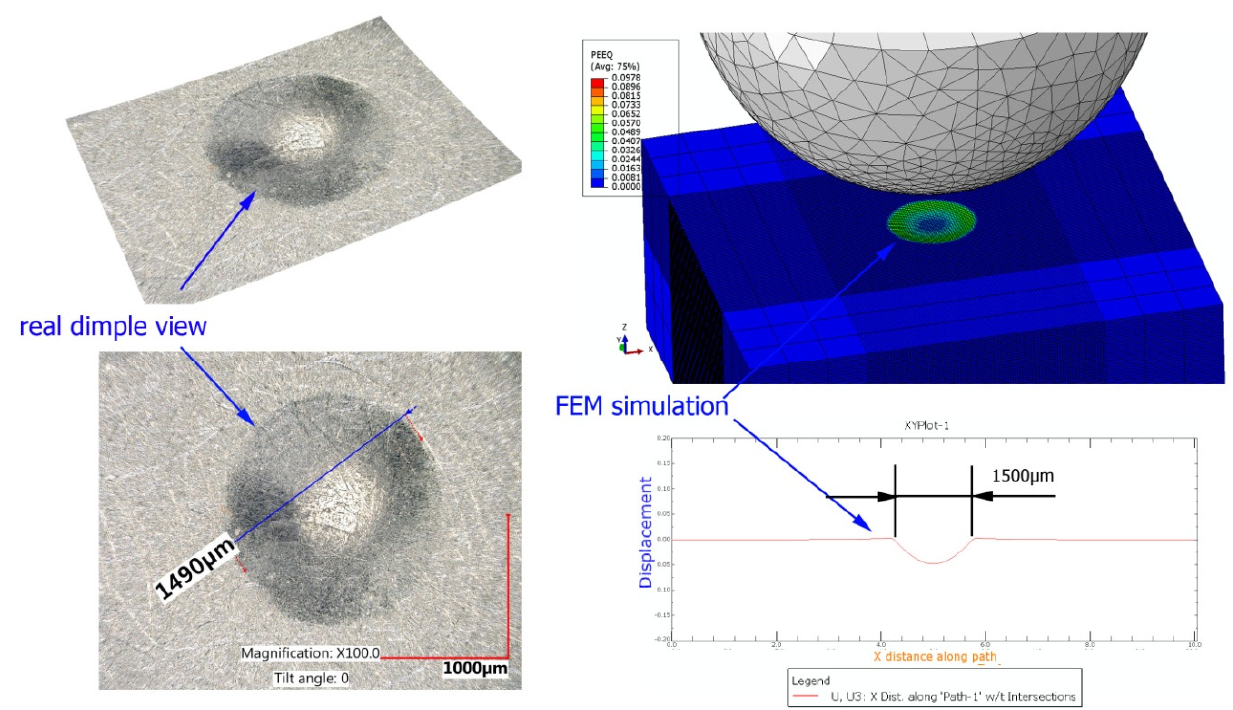
Figure 15. Comparative visualization of a single dimple (impact energy E = 100 mJ, ball diameter D = 10 mm). Comparative results of the real dimples and those obtained by FEM numerical simula- tion for the selected peening element diameters and impact energies are given in Figure